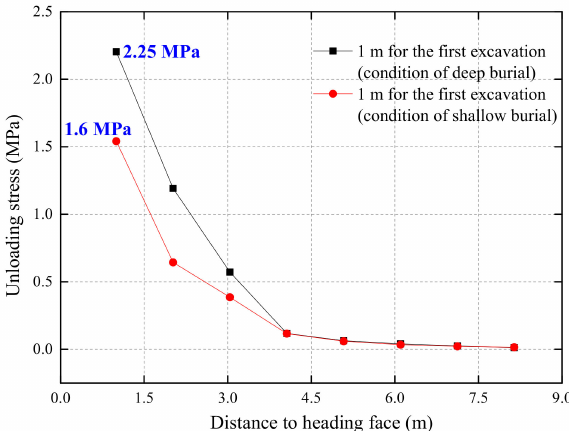
Figure 10. Comparison of unloading disturbance stress of head-on driving between deep-buried high-stress and shallow buried low-stress